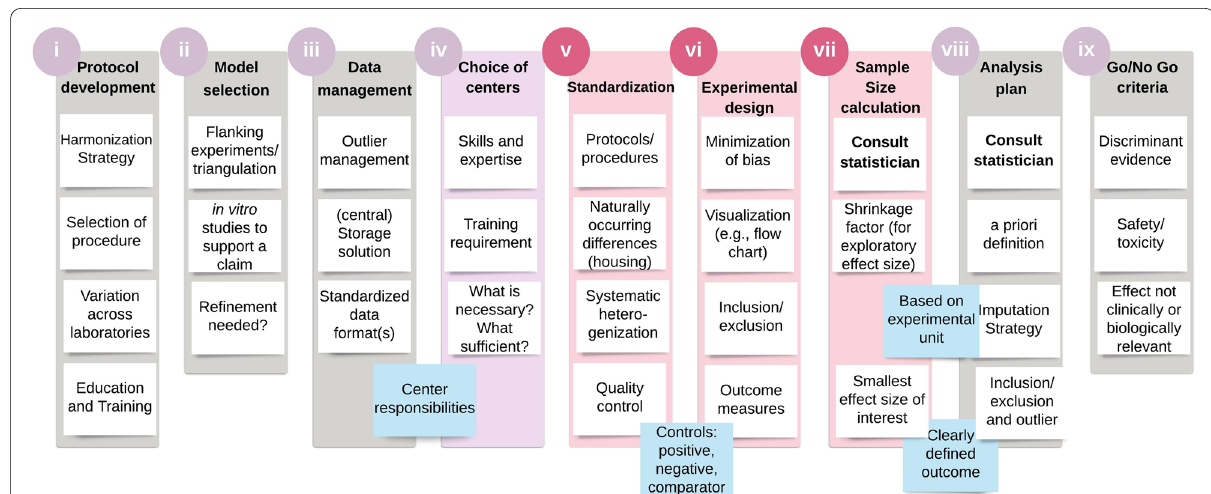
Fig. 2 Steps involved in planning a confirmatory study. Highlighted (pink) aspects (v – vii) are discussed in more detail. Whereas other aspects (grey, (I – iii and viii—ix) are equally important, they are beyond the scope of this manuscript and are solely mentioned in the context of experimental design, standardization and/or sample size calculation. Highlighted in purple (iv) is the choice of participating study centers. Here, skills and expertise as well as training requirements are important selection criteria. Blue notes cannot be assigned to only one aspect, but need to be considered at different stages, e.g., sample size calculation as well as the analysis should be based on the experimental